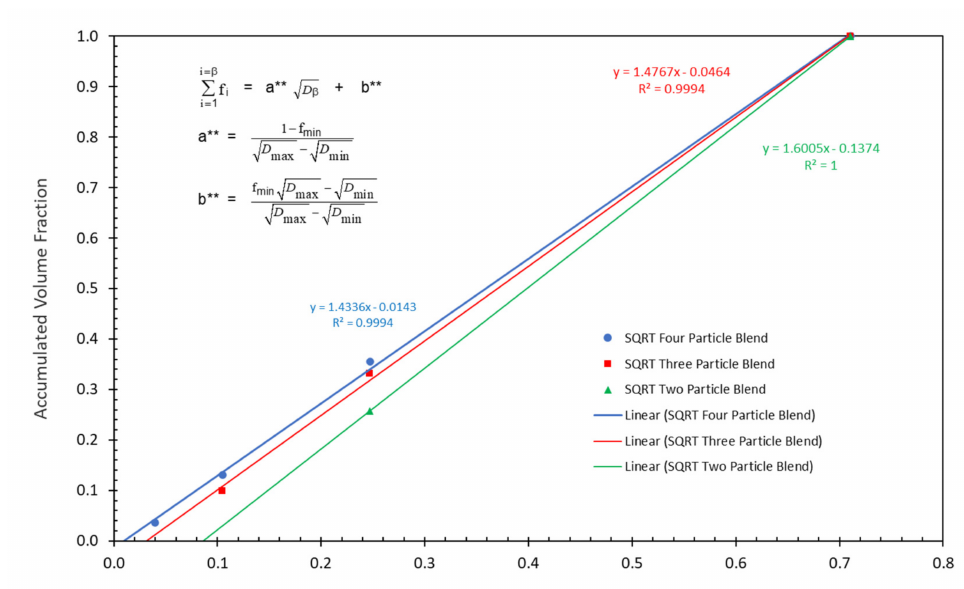
Figure 5. McGeary’s calculated particle blend data vs. square root of particle diameter. Equation (18), as derived in Appendix B, indicates that the optimum ratio between particles, Z Optimum , should be a direct function of the monodisperse packing fraction for spheres, ϕ m . Again, note that Lee [46] found that for loose random monodisperse packing of spheres ( ϕ m = 0.589), whereas for dense random monodisperse packing of spheres ( ϕ m = 0.639). Consequently, the optimum Z results summarized in Table 4 have been calculated for monodisperse packing fractions that range from loose random packing